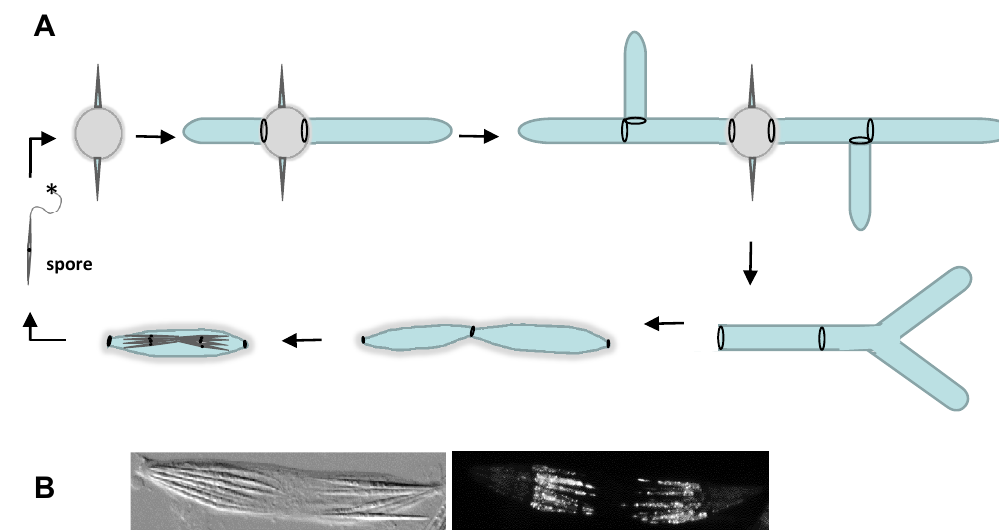
Figure 1. Life cycle of Ashbya gossypii . ( A ) A single spore (on the left depicted with its whip-like appendage marked by an asterisk) germinates, swells and forms a germ cell by growing isotropically. Then polarity establishment sets in and bipolar germ tubes are formed. A young mycelium grows and forms lateral branches. Upon maturation tips start bifurcating and at the end of the growth phase, e.g., in the interior of a colony, hyphae develop into sporangia, fragment and generate endospores. The ascus disintegrates and spores are set free. Spores form bundles by attaching via terminal whip-like appendages. Ashbya is a homothallic fungus, i.e., a single spore can form a sporulating mycelium. ( B ) Bright field (left) and fluorescent (right) microscopy images of a sporangium. The ascus was fixed with formaldehyde and stained with rhodamine phalloidin (see text for details). Scale bar is 10 µ